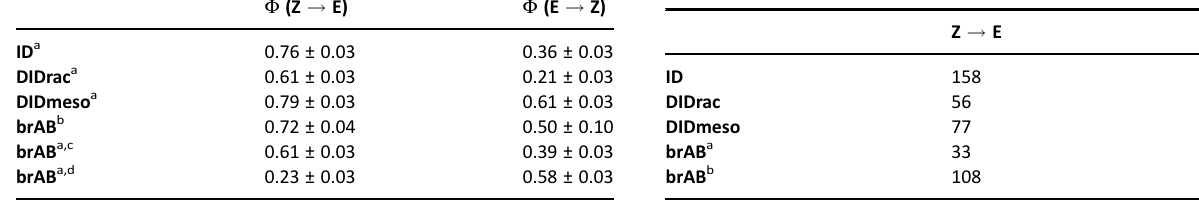
Table 5. Quantum yields for the ID , DIDrac , and DIDmeso iso- mers in comparison to the parent system brAB . Table 6. Time to the S 1 = S 0 PI for the ID , DIDrac , and DIDmeso isomers in comparison to the parent system brAB